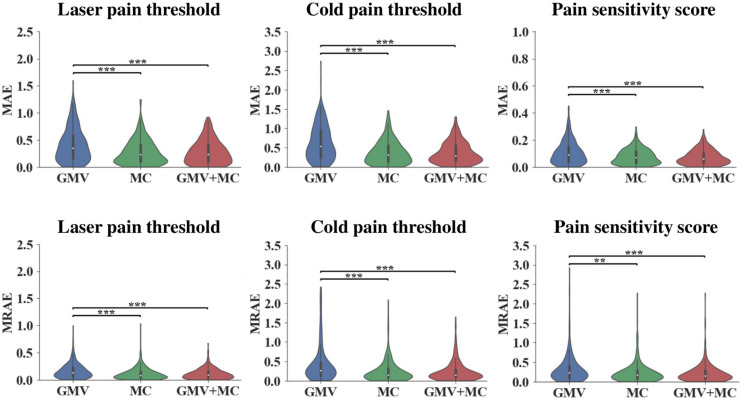
Prediction errors of using different feature sets (GMV, MC, and GMV + MC) to predict three types of pain thresholds (laser pain threshold, cold pain threshold, and pain sensitivity score). **Indicates P < 0.01, *** indicates P < 0.001, two-sided Wilcoxon rank-sum test.